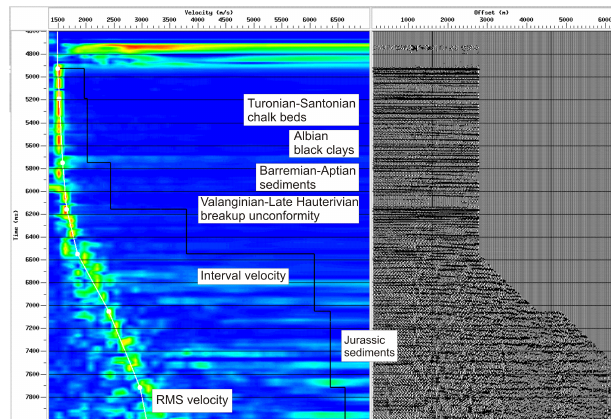
Fig. 12. Stacking and interval velocity trends for a typical depth profile through the Mentelle Basin. Note the significant increases in interval velocity associated with the Valanginian-Late Hauteriv- ian breakup unconformity (volcanic composition) and deeper buried more compacted Jurassic